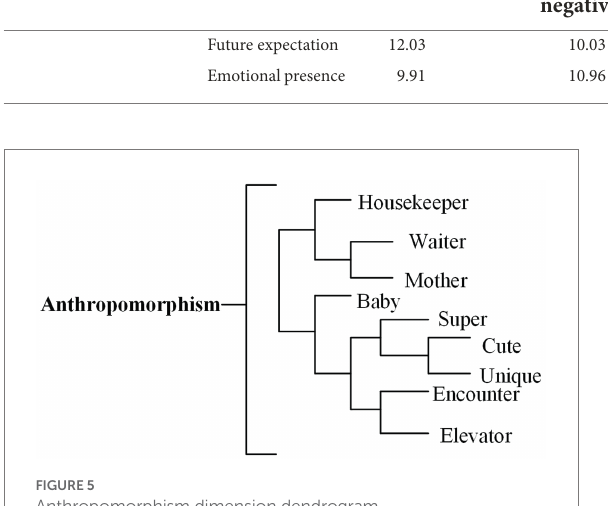
FIGURE 5 Anthropomorphism dimension